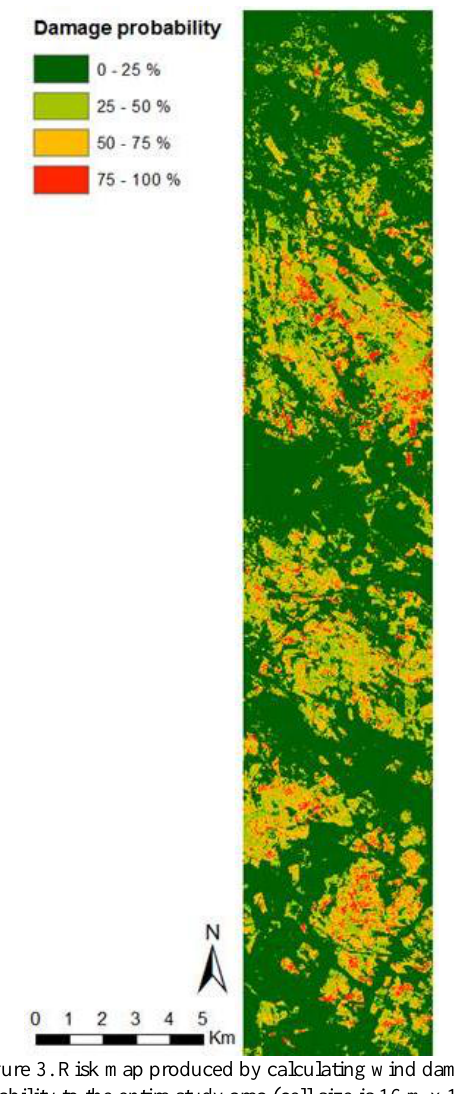
Figure 3. Risk map produced by calculating wind damage probability to the entire study area (cell size is 16 m x 16